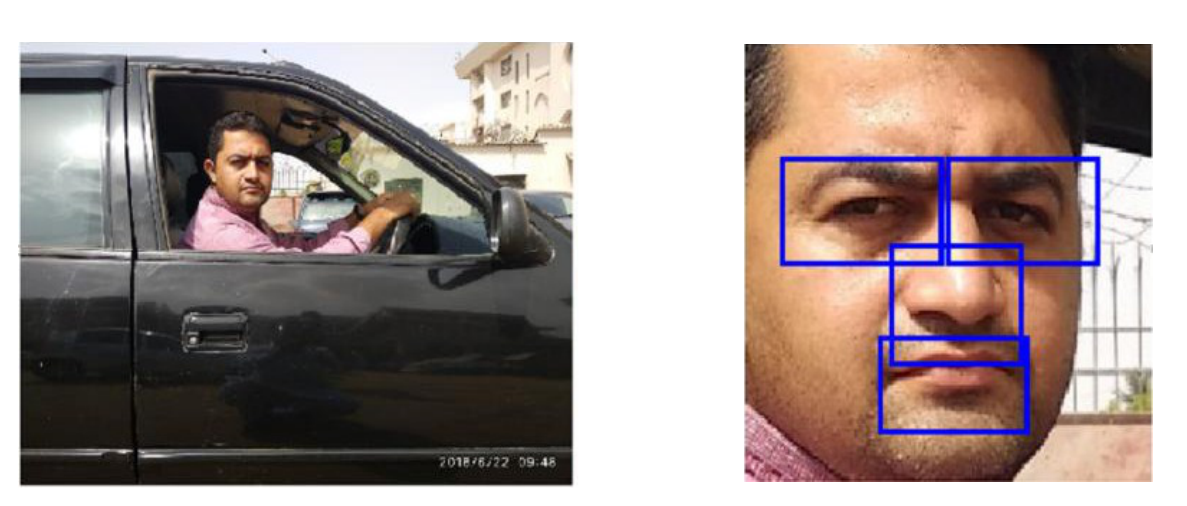
FIG. 4. (b) FACIAL COMPONENT DETECTION OF M.